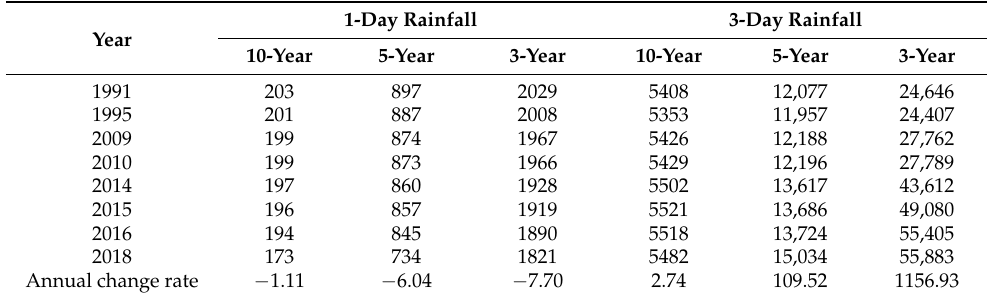
Table 6. The area corresponding to the average draining formula under 1-day and 3-day rainfall with different return periods ( F A , in km 2